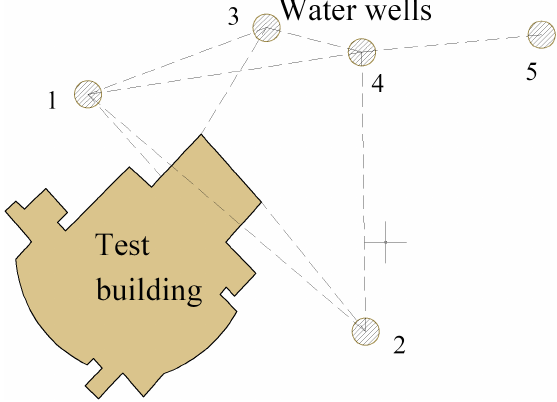
Figure 2. Layout of test building and water